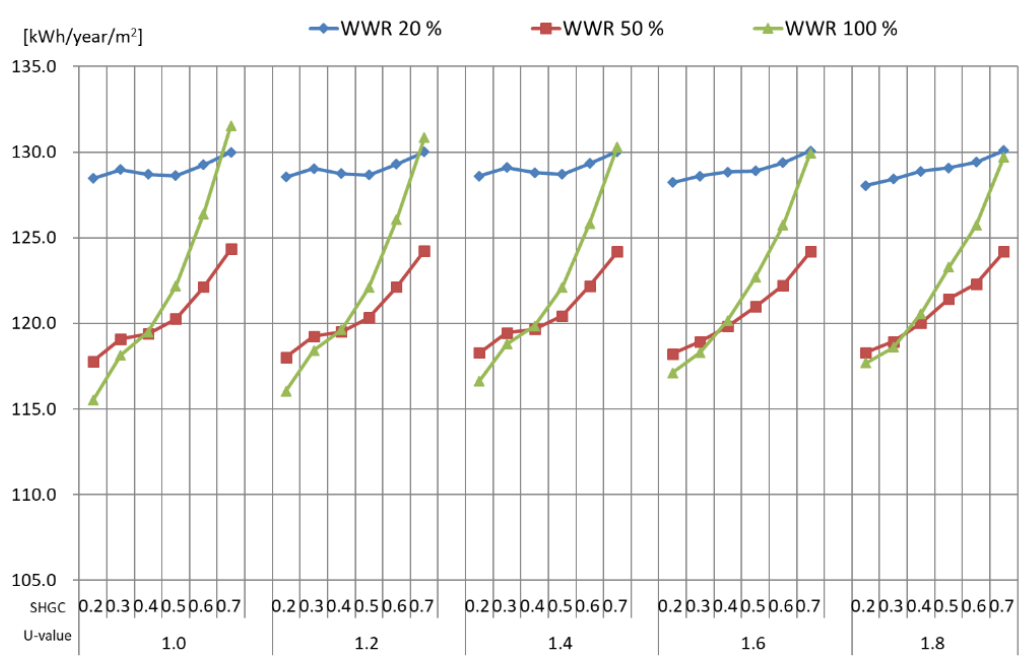
Figure 9. Energy demands per area according to the WWR and window properties 2.